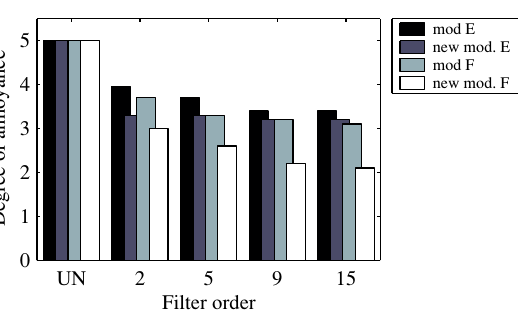
Figure 6. The target curve (modified F (c1)) and PSDs of the filters of 9 th order designed by the procedure I without (c2) and with implementation of the proposed improvement (c3).